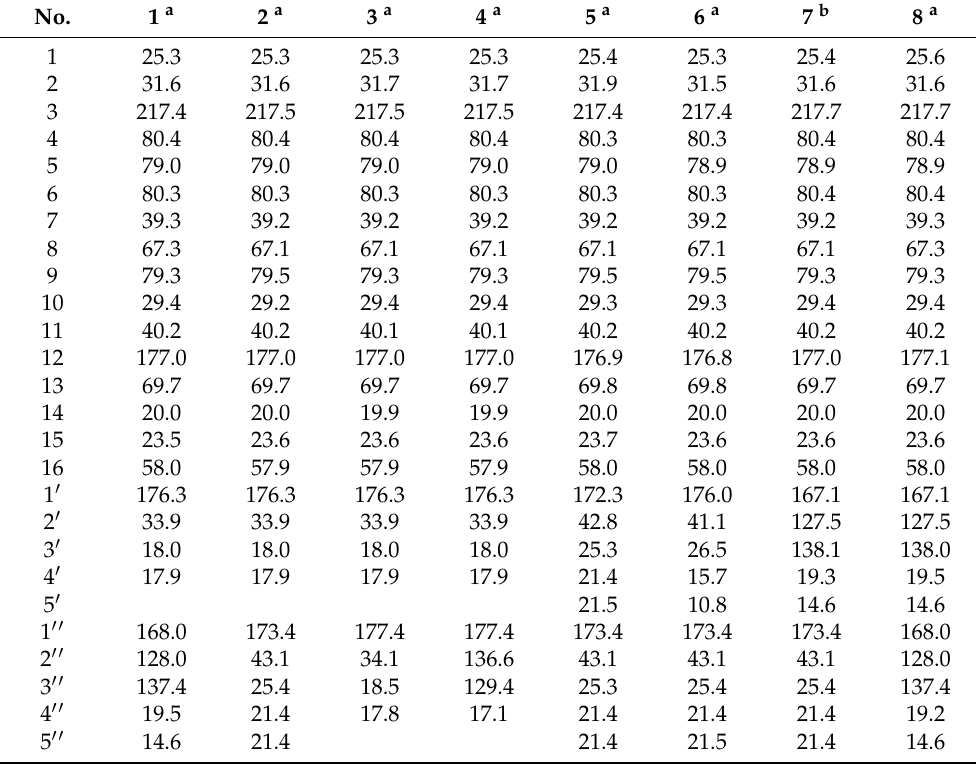
Table 2. 13 C NMR spectroscopic data for compounds 1 – 8 ( δ in ppm).